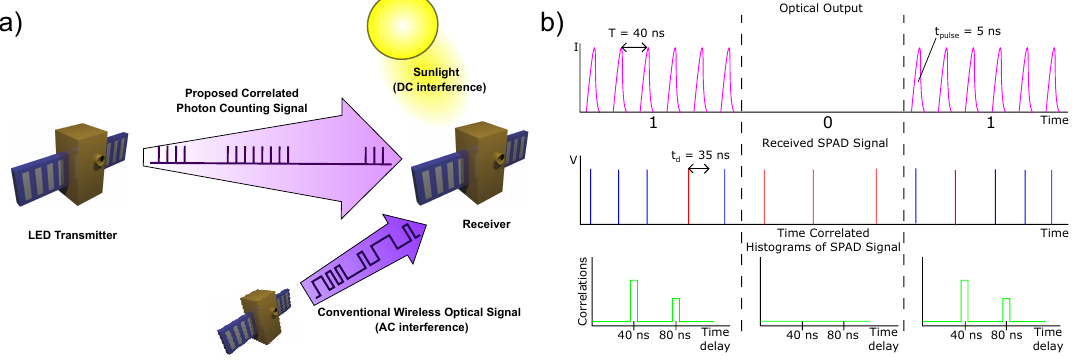
Figure 1. ( a ) Application scenario for inter-satellite communications: the proposed signal encodes data in trains of time-correlated optical pulses and is compatible with low power consumption LED emitters. It is resilient against constant background such as sunlight and also insensitive to most AC background such as conventional wireless optical signals. ( b ) Schematic of the transmission scheme used. LED output on transmission of “0” and “1” ( top ), SPAD response to the LED signal ( middle ) and the calculated correlation histograms for each data interval ( bottom